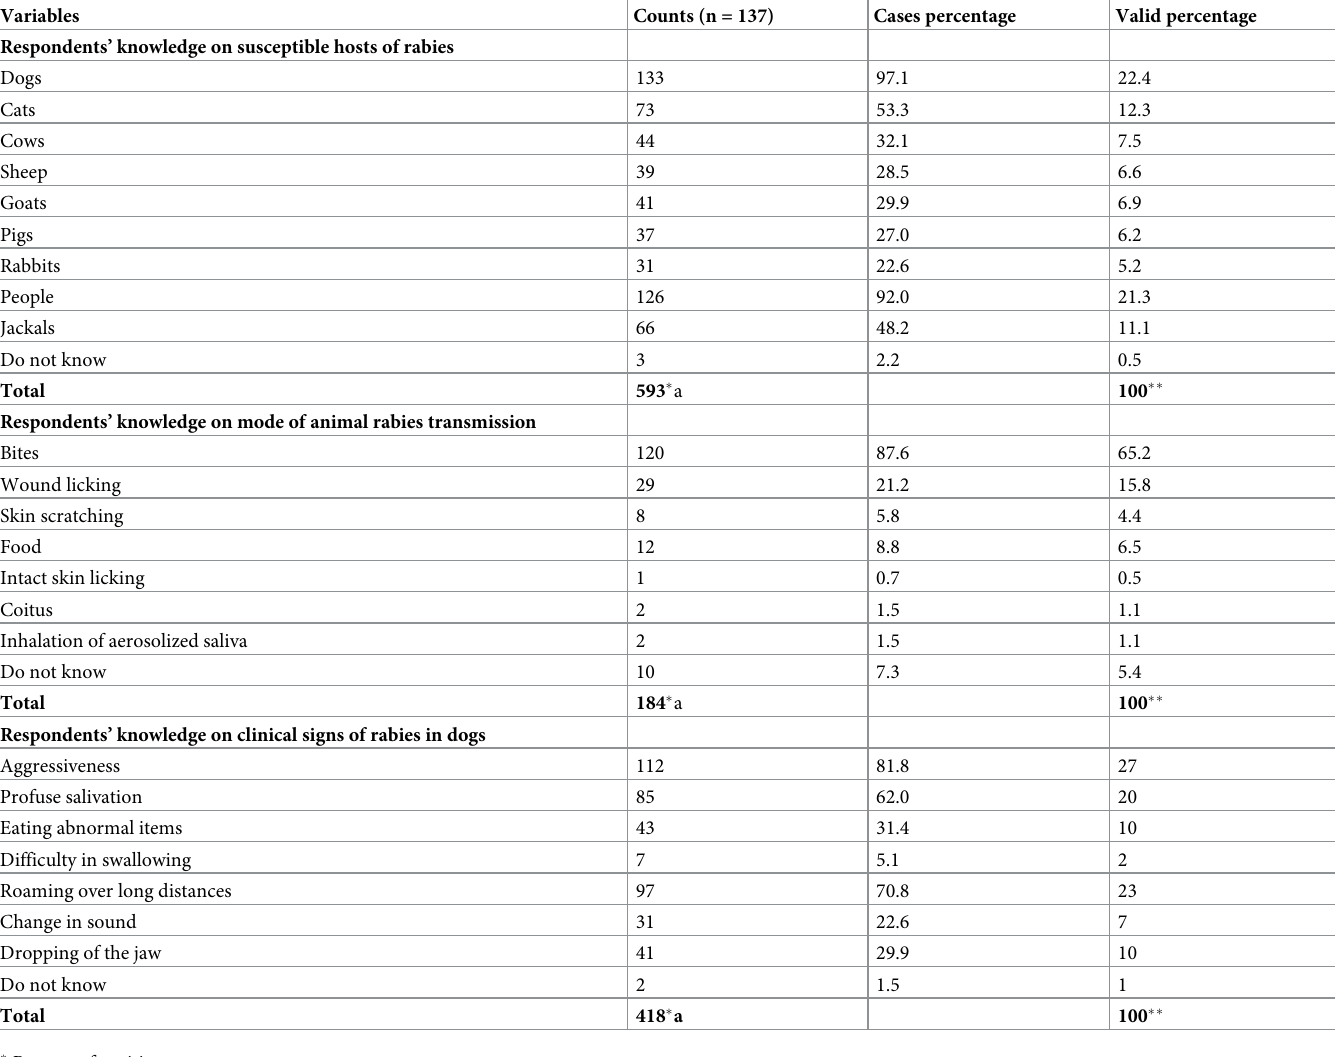
Table 2. Respondents’ knowledge on susceptible hosts of rabies, transmission modes and clinical signs of rabies in dogs.